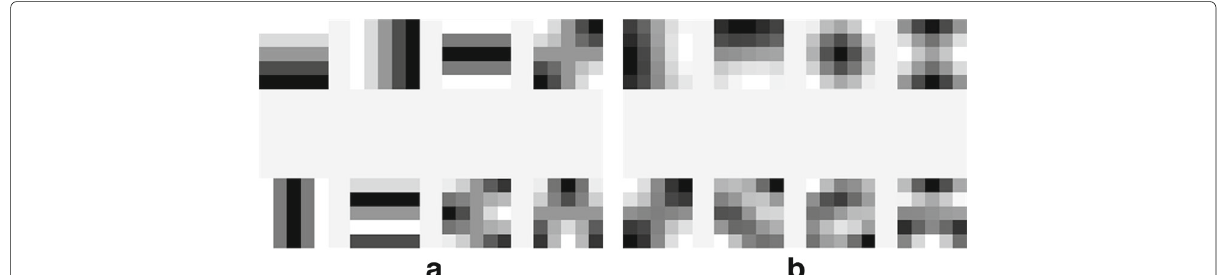
Fig. 2 ICANet filter: The figure shows the filters learned in the ICANet volume base, with the filter size and filter number for both phases set to 11 × 11 and 8, where a and b are the first and second stages, respectively, of the filter in the ICANet convolutional layer